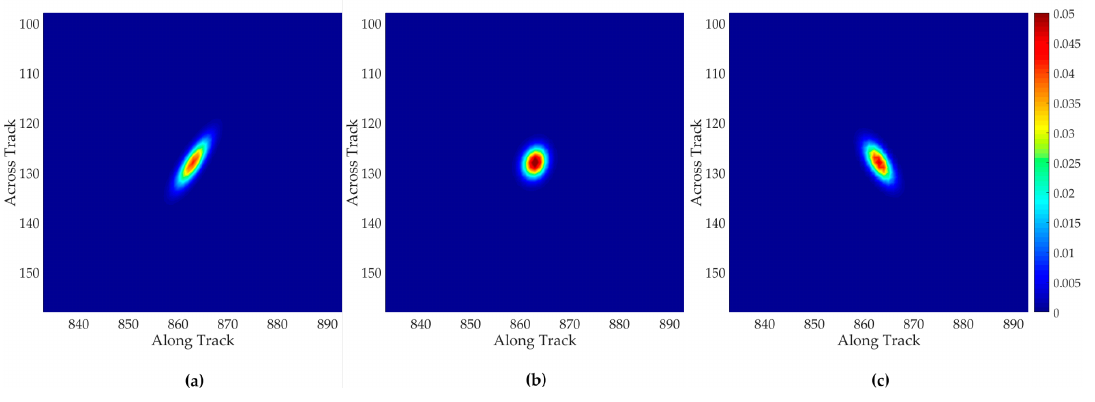
Figure 4. The PSFs in the image domain. ( a ) The 2nd PSF ( i = 67); ( b ) The 4th PSF ( i = 127); ( c ) The 6th PSF ( i = 187).